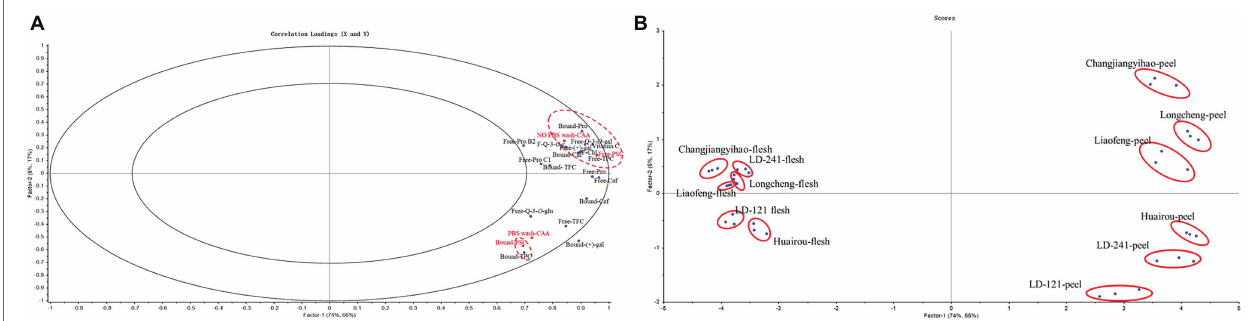
FIGURE 5 | PLS plots of the correlations (A) and Scores (B) between phenolics profile and antioxidative activities in kiwi berry flesh and peel extracts. The antioxidative activities are in red font and phenolic profile are in blue font. Abbreviations of phenolic compounds: Pro, Protocatechuic acid; Caf, Caffeic acid; Chl, Chlorogenic acid; Qui, Quinic acid; (+)-gal (+)-gallocatechin; Pro B2, proanthocyanidin B2; Pro C1, proanthocyanidin C1; Q-3- O -glu quercetin-3- O -glucoside; Q-3- O -r quercetin-3- O -rutinoside; Q-3- O -gal, Quercetin-3- O